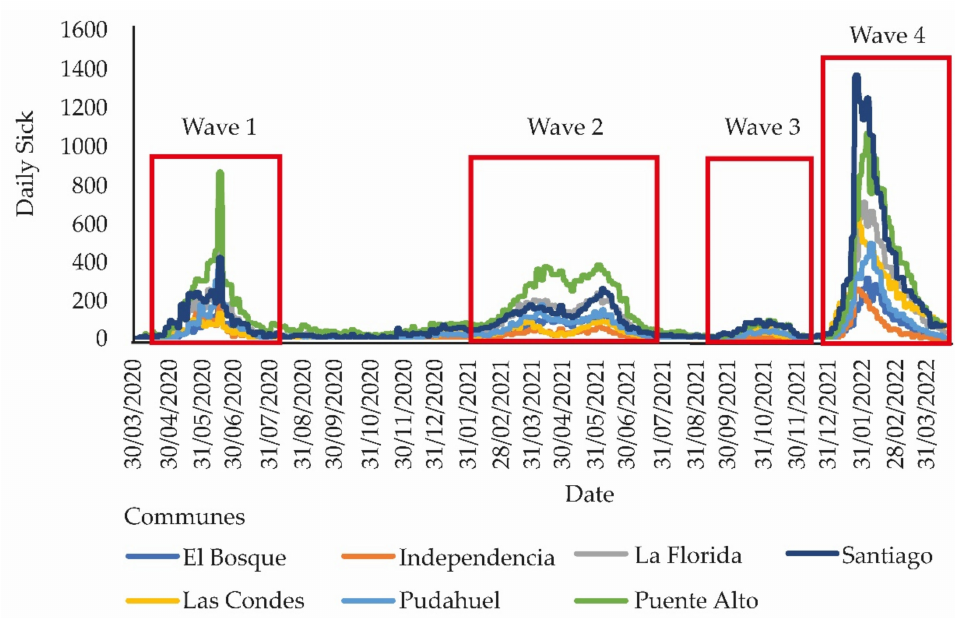
Figure 4. Contagion waves consisting of maximum number of daily sick people, according to the seven communes. The rectangles framed in red are to visualize the waves and the period of occurrence.